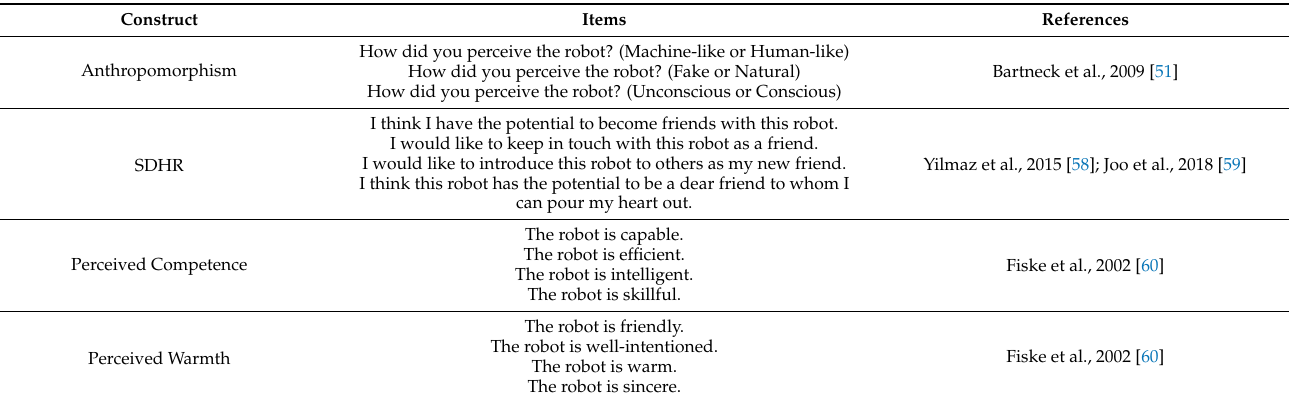
Table 2. Measurement items of each